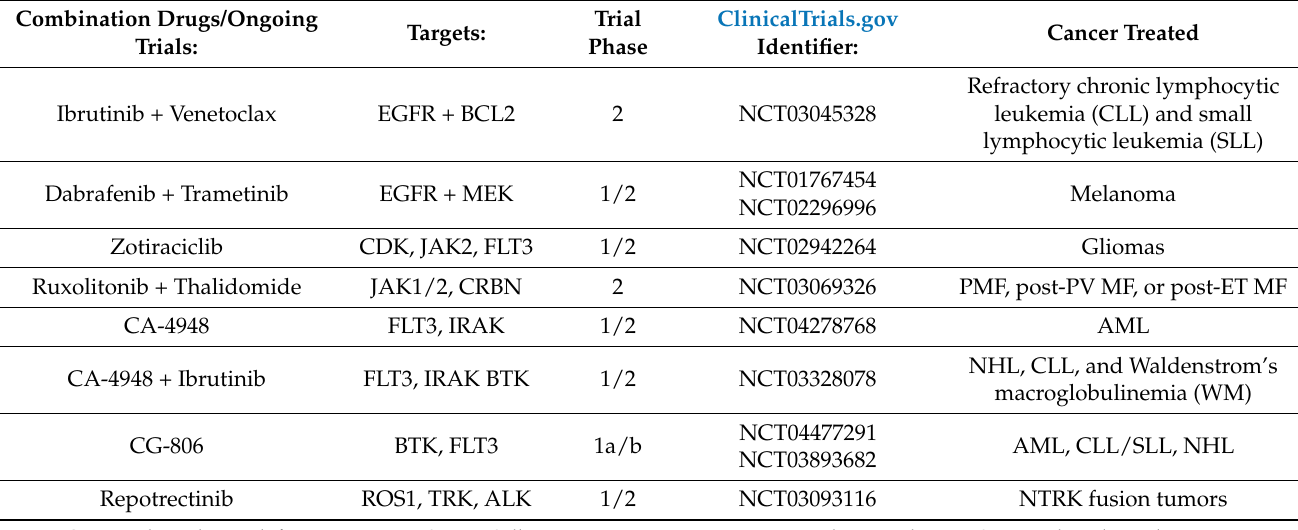
Table 3. Current combination drug trials using multiple selective inhibitors, dual-targeted therapies, or multikinase